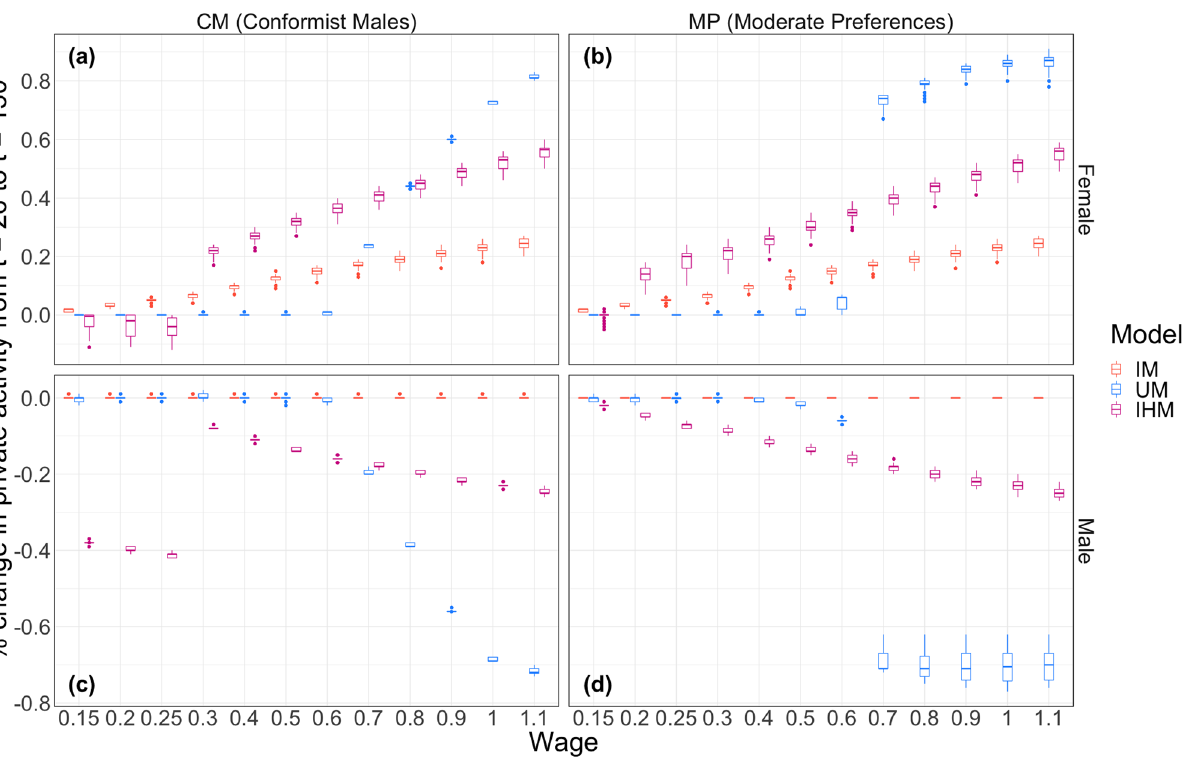
Figure 3. Change in time spent on private activity by agents from t = 26 (after wage change) to t = 150 (simulation end) under different wage change conditions. Colors indicate the model used in the simulation, i.e. IHM (intra-household model), IM (individual-based model) or UM (unitary household-based model). Panels refer to the agents and conformity condition: ( a ) Female agents’ behavior under the CM condition; ( b ) female agents’ behavior under the MP condition; ( c ) male agents’ behavior under the CM condition; and ( d ) male agents’ behavior under the MP